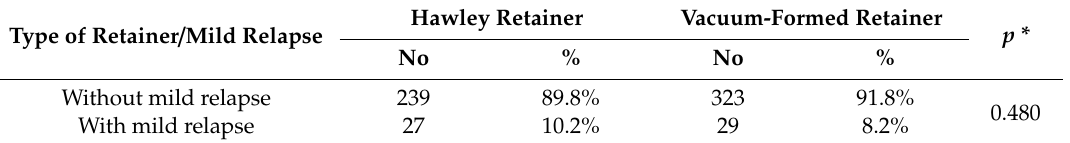
Table 7. Distribution of the patients according to the existence of mild relapse and type of retainer.